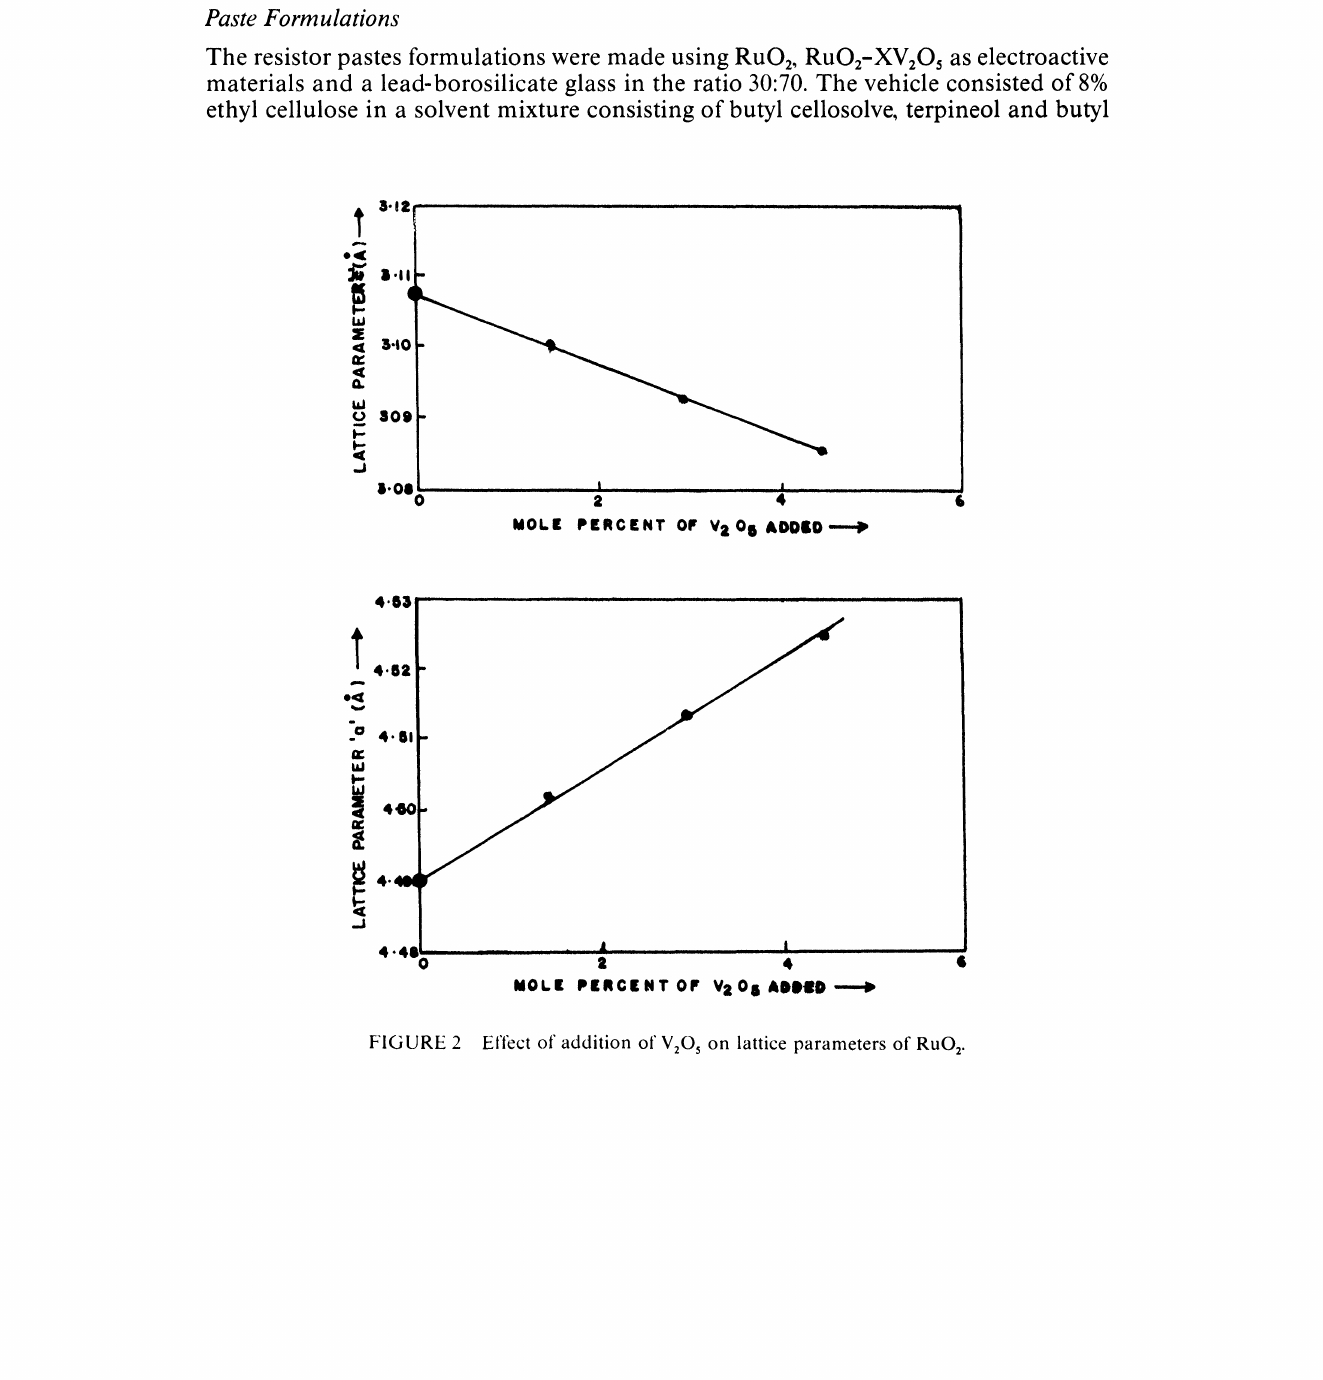
FIGURE 2 Effect of addition of V20 on lattice parameters of